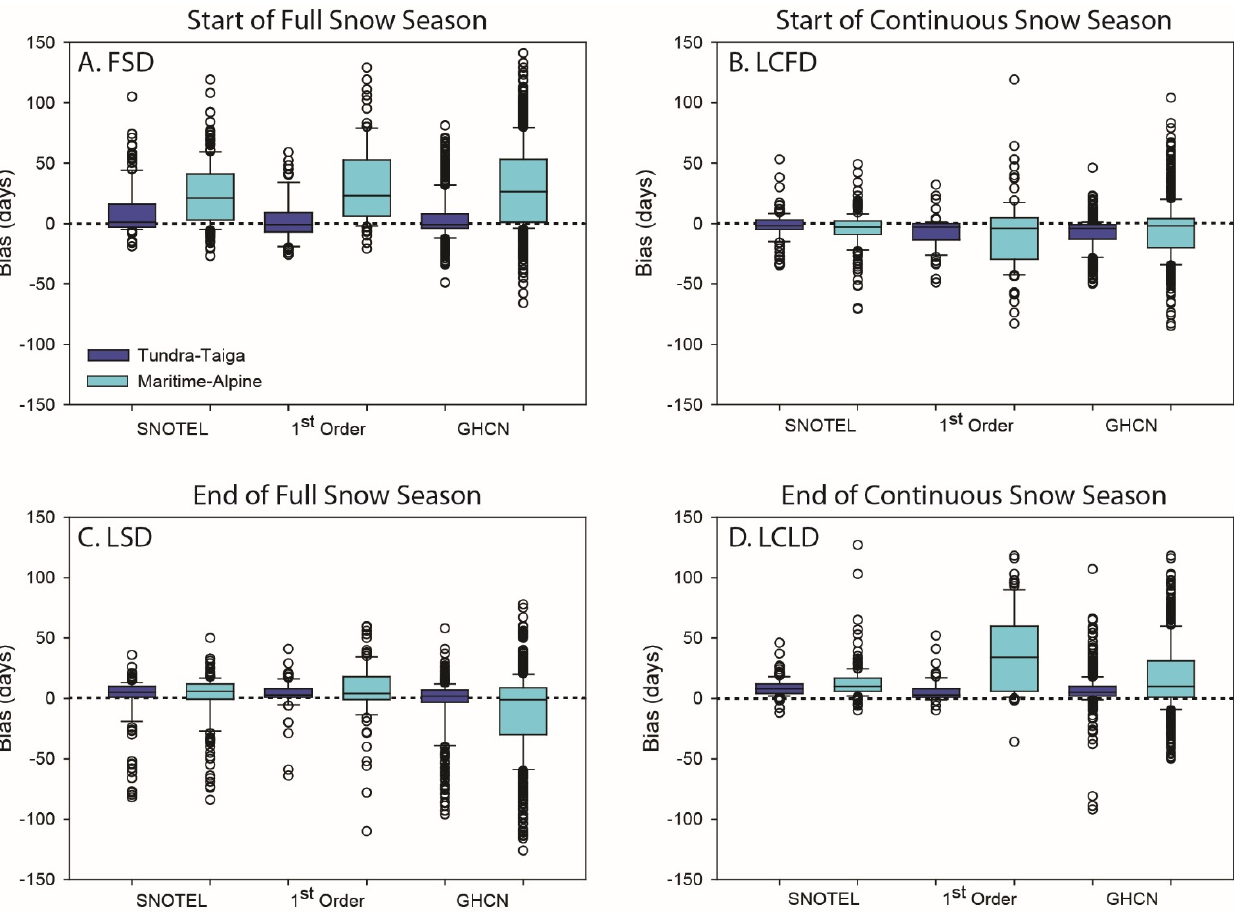
Figure 5. Boxplots summarizing bias (observed–predicted) for four MODIS-derived snow season metrics: ( A ) FSD, ( B ) LCFD, ( C ) LSD and ( D ) LCLD, compared to three in situ weather station types. The boxes depict the median, 1st and 3rd quartiles; the whiskers depict the 10th and 90th percentiles; and outliers are depicted by the open circles. Colors correspond to combined snow class type